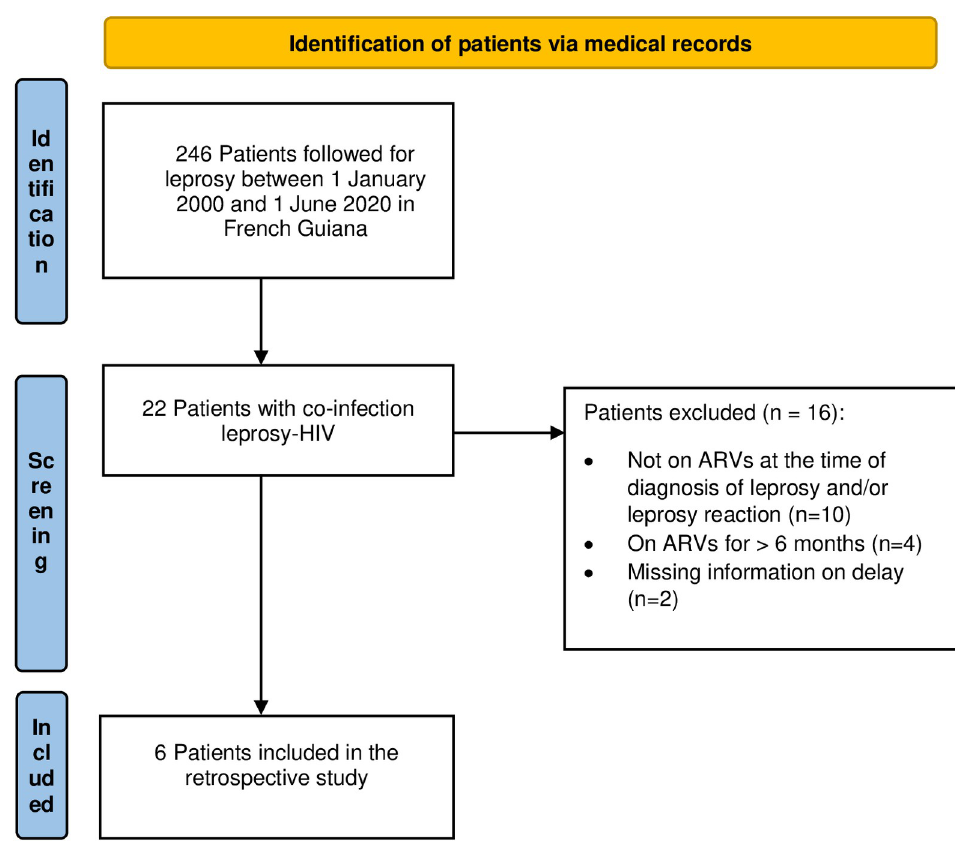
Fig 1. Flow chart of the retrospective study of leprosy as IRIS in French Guiana between 2000 and 2020.